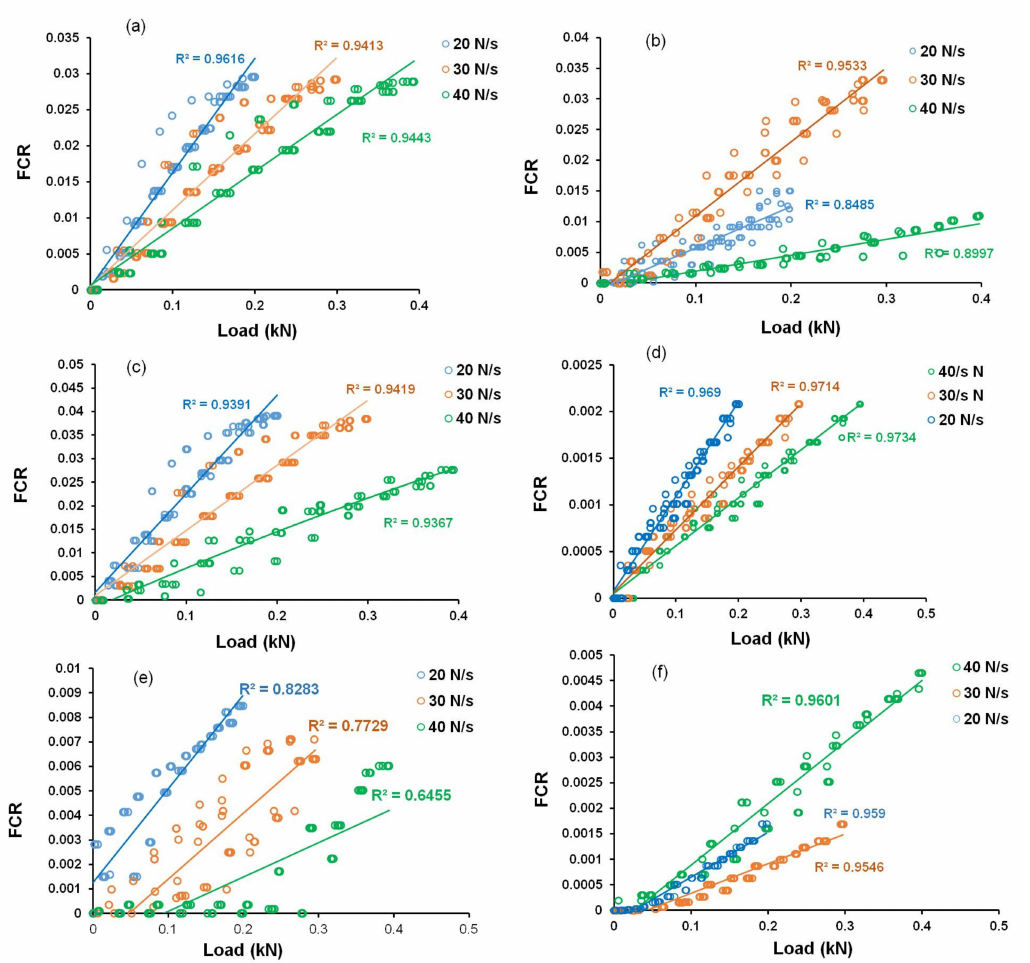
Figure 18. FCR-load correlation of MWCNT-based hybrid cementitious composites: ( a ) 0.25% CF + 0.1% MWCNT, ( b ) 0.25% CF + 0.15% MWCNT, ( c ) 0.5% CF + 0.1% MWCNT, ( d ) 0.5% CF + 0.15% MWCNT, ( e ) 0.75% CF + 0.1% MWCNT and ( f) 0.75% CF + 0.15%